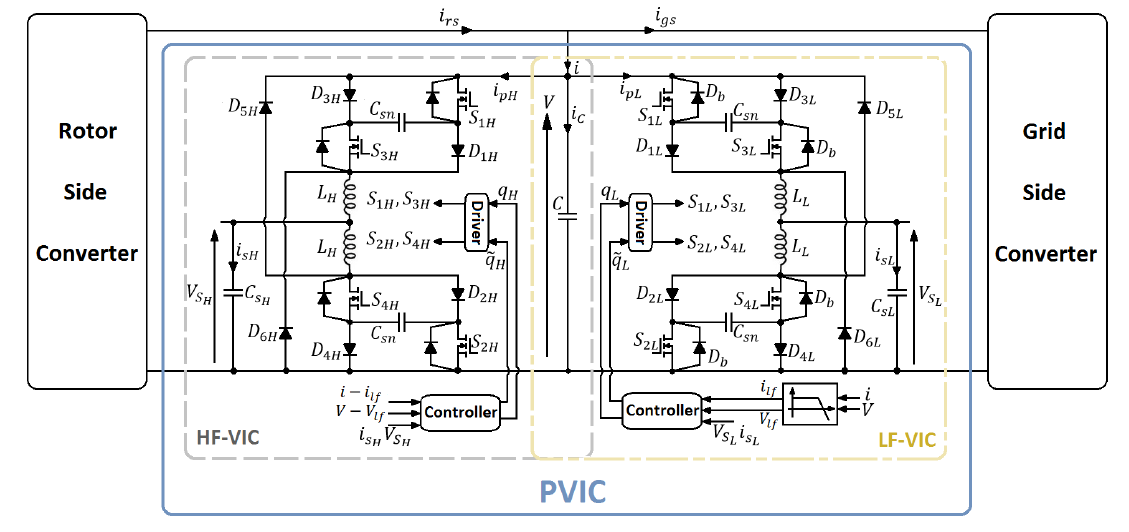
Figure 4. The PVIC in place of a DC-link